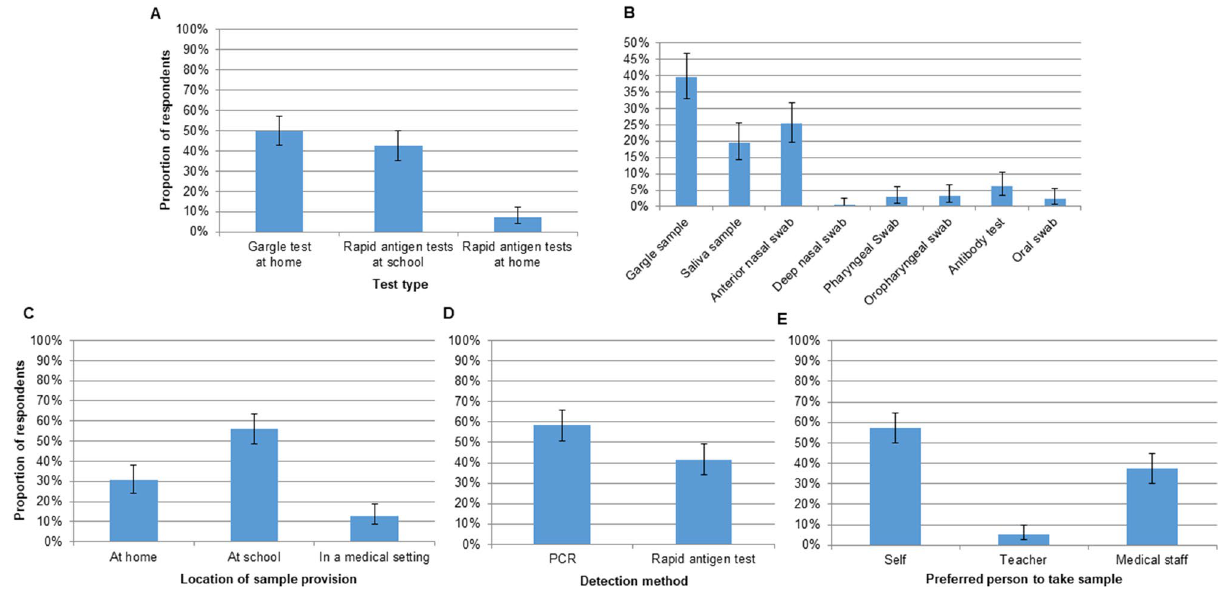
Figure 7. Responses to Questionnaire 4, in which participants were provided with multiple choice options regarding SARS-CoV-2 testing. ( A ) Reasons for favouring a particular SARS-CoV-2 test type (N = 188). ( B ) Choice of sampling method for SARS-CoV-2 testing (N = 209). ( C ) Choice of location for provision of test sample (N = 185). ( D ) Choice of SARS-CoV-2 detection method (N = 169). ( E ) Preference of a particular person to take test samples (N = 185). Error bars: 95%